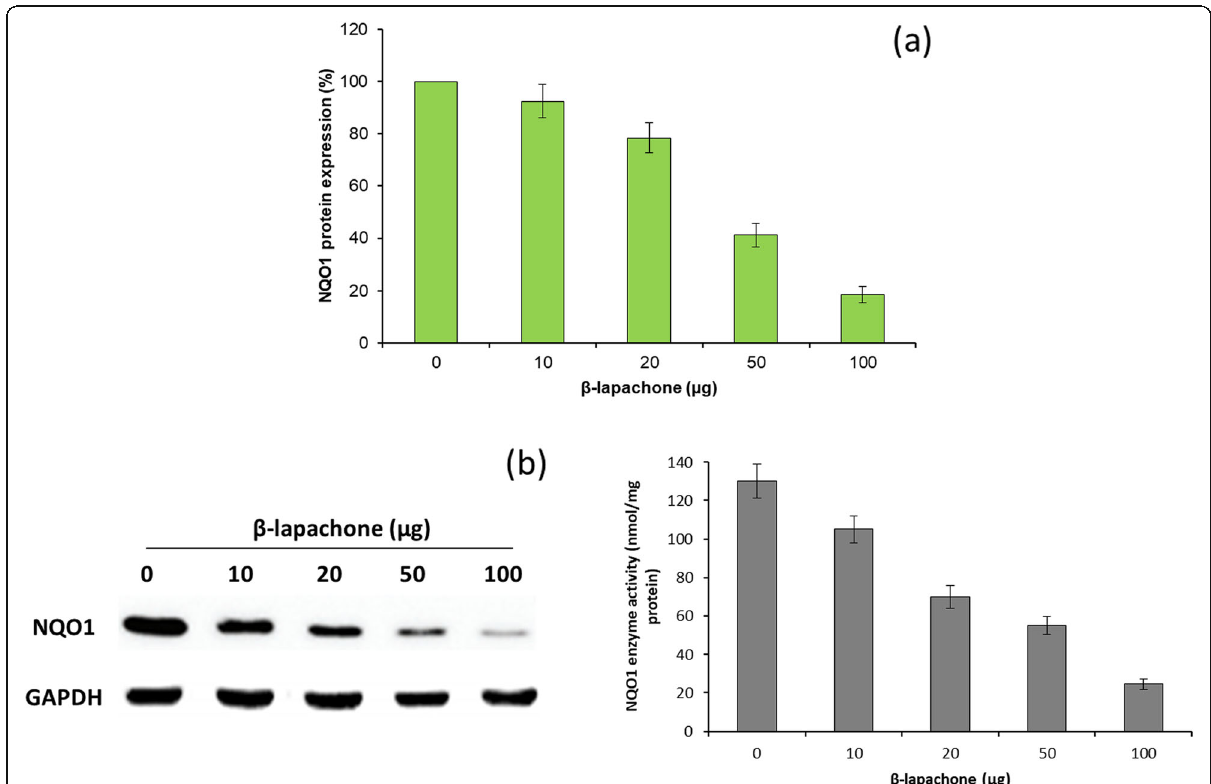
Fig. 3 a Effect of concentration-dependent activity of ß-lap on the NQO1 activity of Cal33 cancer cells by the enzymatic method. b Effect of concentration-dependent activity of ß-lap on the NQO1 protein levels by western blot analysis using GAPDH as a housekeeping